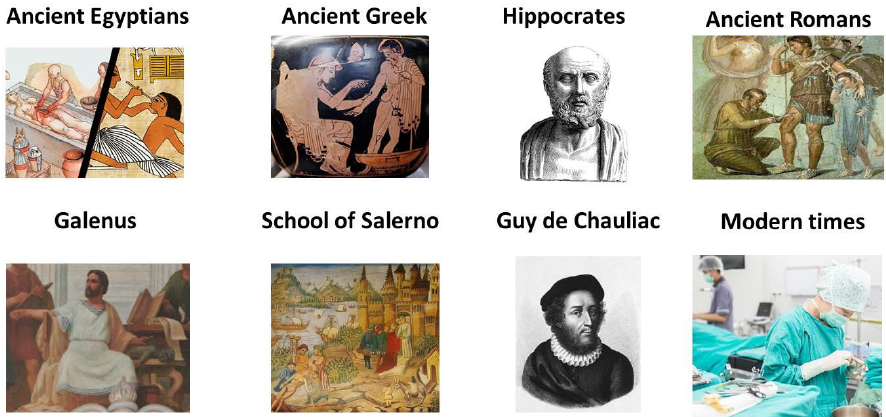
Figure 2. Main physicians and milestones of medicine for wound treatment from ancient to mod- ern times (sources: www.wikipedia.com, www.youtube.com, accessed on 10 April 2021)